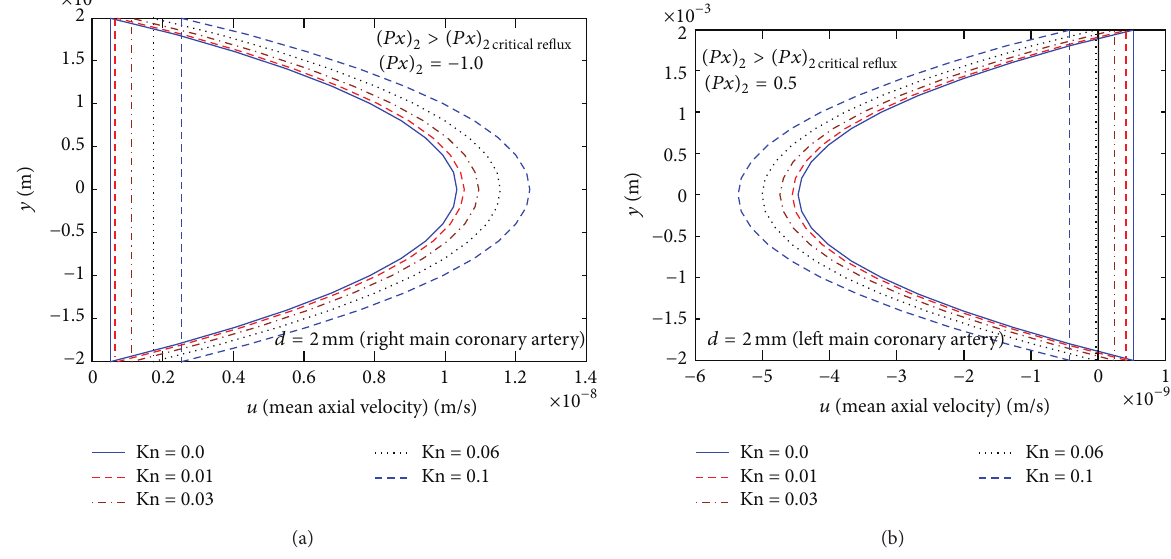
Figure 7: (a) Mean axial velocity (m/s) distribution at (𝜕𝑝/𝜕𝑥) 2 < (𝜕𝑝/𝜕𝑥) 2 critical reflux ( (𝜕𝑝/𝜕𝑥) 2 = − 1 . 0). (b) Mean axial velocity (m/s) distribution at (𝜕𝑝/𝜕𝑥) 2 > (𝜕𝑝/𝜕𝑥) 2 critical reflux ((𝜕𝑝/𝜕𝑥) 2 = 0 . 5 )